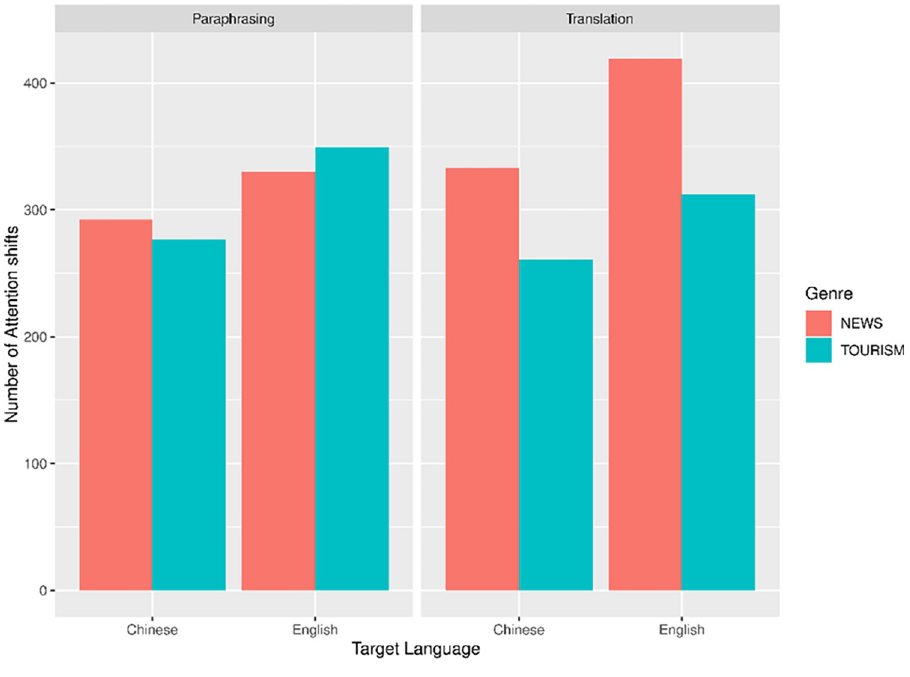
Fig 6. Attention shift between ST and TT regions.